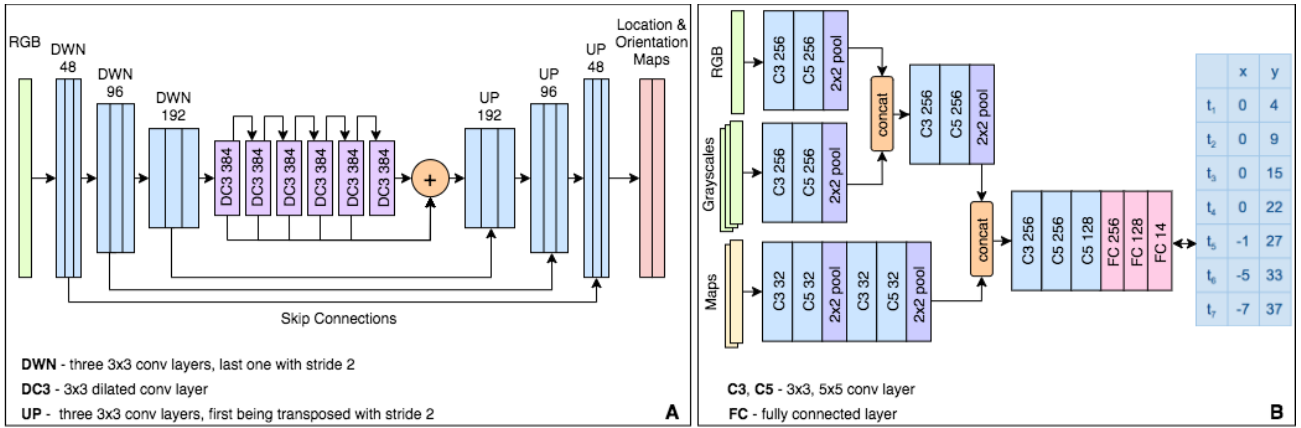
Figure 4. The network architectures we propose for localization ( A ) and navigation ( B ). The localization module A outputs the vehicle 2D pose (location and orientation) using a segmentation representation (a dot on the map for localization, and a half dot for orientation). The navigation module ( B ) outputs the predicted future trajectory (next seven seconds) by seven 2D points, one per second in the